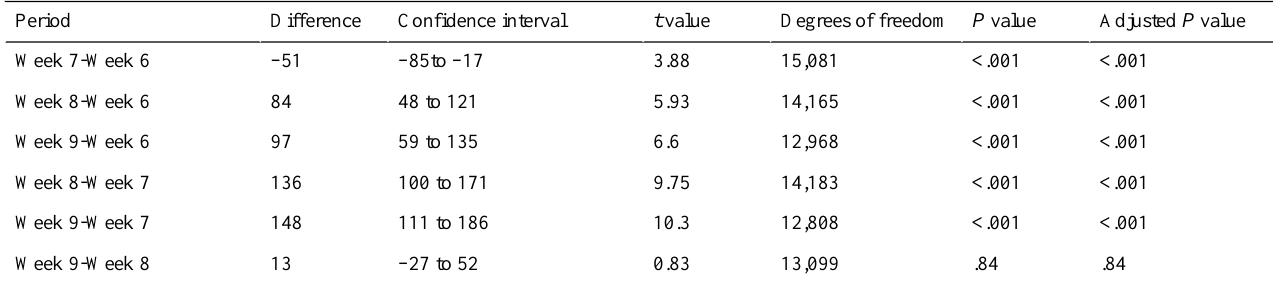
Table 1. Statistical comparisons between weeks in the Pre–COVID-19 period.